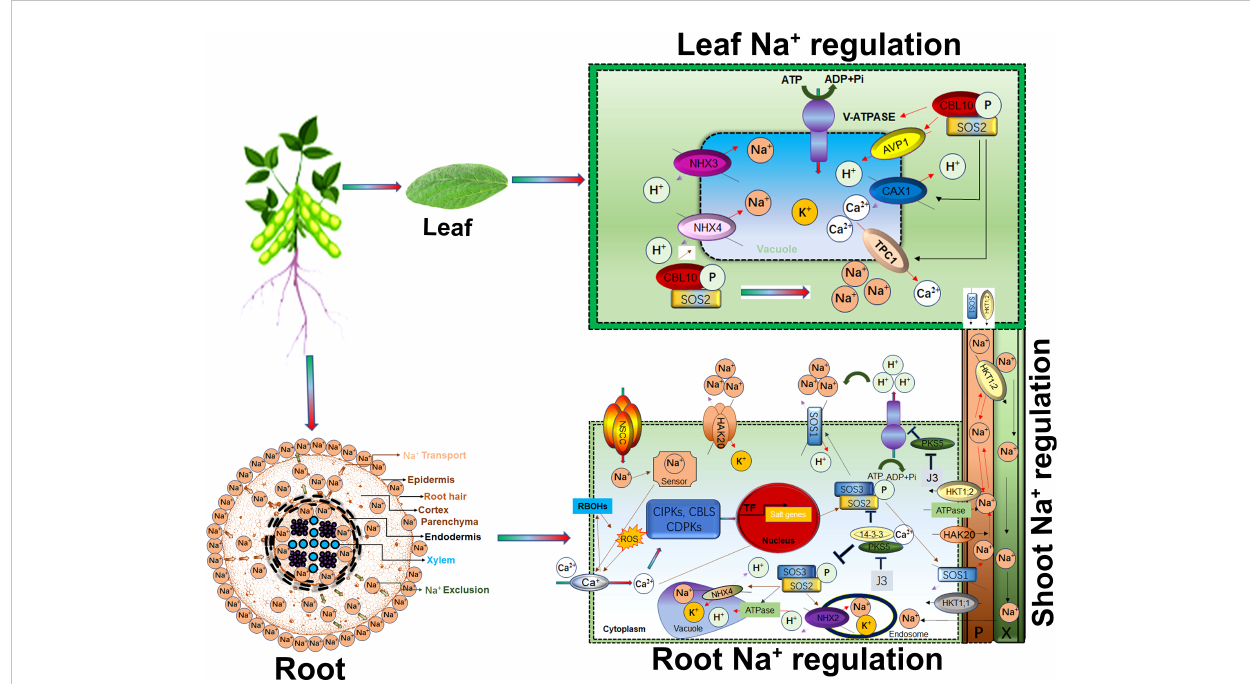
FIGURE 2 Salt (Na + ) regulation in root, shoots transportation and leaves response Higher Na + concentration around the root epidermis is eventually transported through membrane pores. Apoplastic and symplastic pathways are critical in Na + ions movement in membrane. Ca 2+ , RBOHs and ROS cascade induces Ca 2+ import upon higher accumulation of Na + through NSCC within cytoplasm. Ca 2+ mediates alteration of CIPKs-CBLs-CDPKs modules transcriptional pro fi le thus enhanced the Na + /H + and K + /H + transportation and vacuole storage. SOS2-SOS3 complex activate the SOS1 for Na + partitioning, exclusion and transportation to leaves. In leaves, CBL10-SOS2 complex trigger the storage or Na + exclusion to shoots by activation of different transporters. HKT1;2 is involved Na + recirculation from shoots to